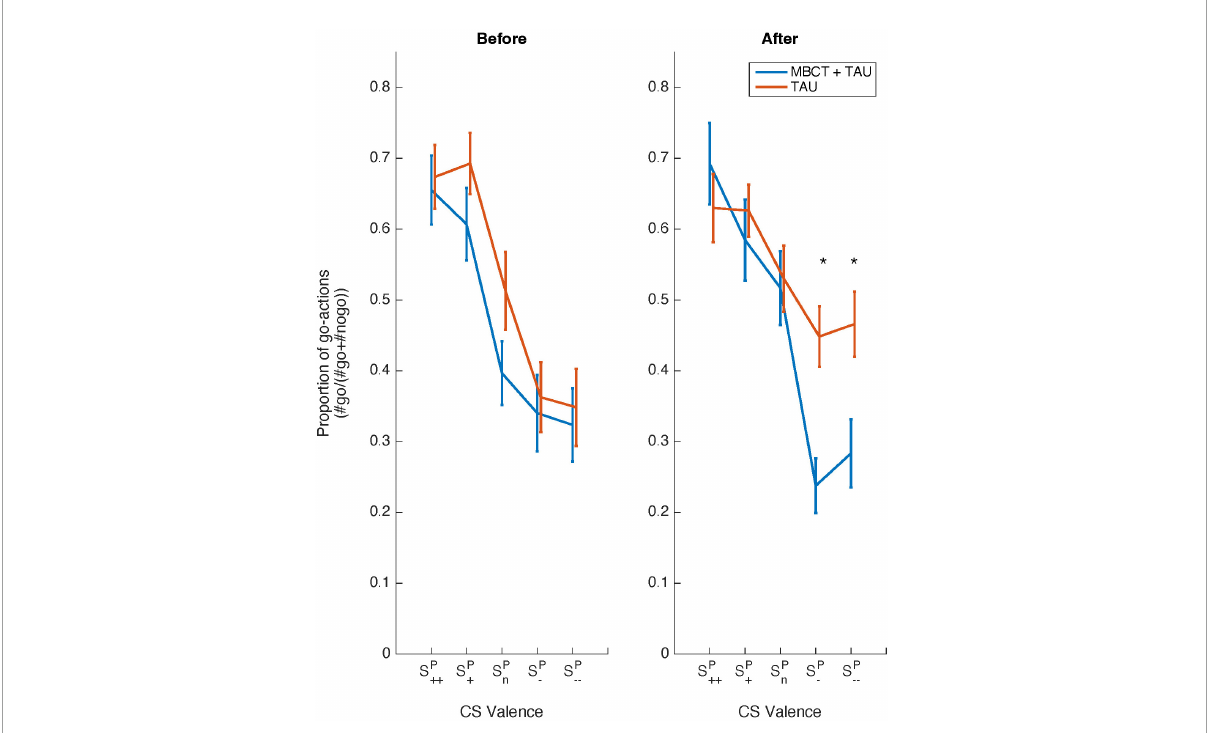
FIGURE3 Behavioral data from the Pavlovian-instrumental transfer stage as a function of Treatment. Shown are choice data (proportion of go-actions) as a function of Pavlovian CS Valence (S P ++ /S P + /S P n /S P - /S P –– ) and Day (before vs. after) for a group receiving mindfulness based cognitive therapy and treatment as usual (MBCT+TAU, blue line) and a group receiving treatment as usual (TAU) only (red line). The group receiving MBCT shows increased aversive inhibition after MBCT ( p < 0.05) compared to the TAU only group. Error bars represent standard errors of the